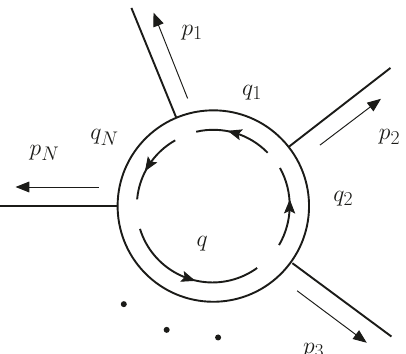
Figure 2. scalar loop with N external legs. The momenta p 1 , . . . , p N are taken as outgoing, while the loop momentum q flows